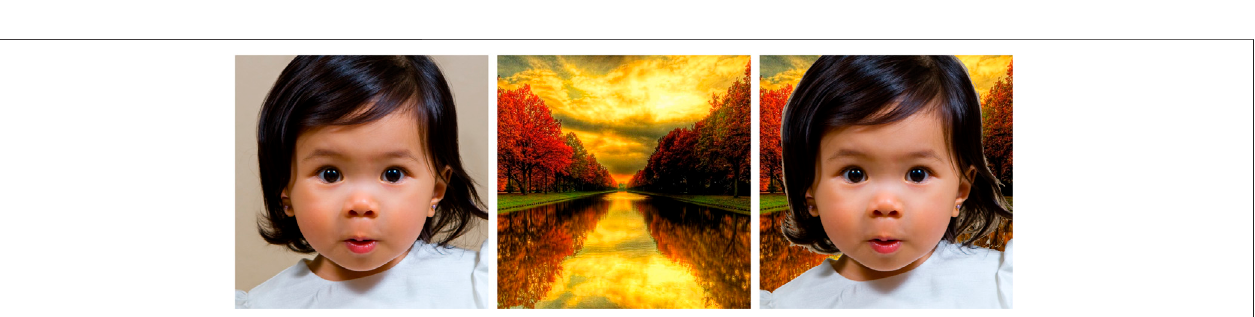
FIGURE 5 | Example of splicing operation in FFHQ dataset. From left to right: original image, real background, spliced image.